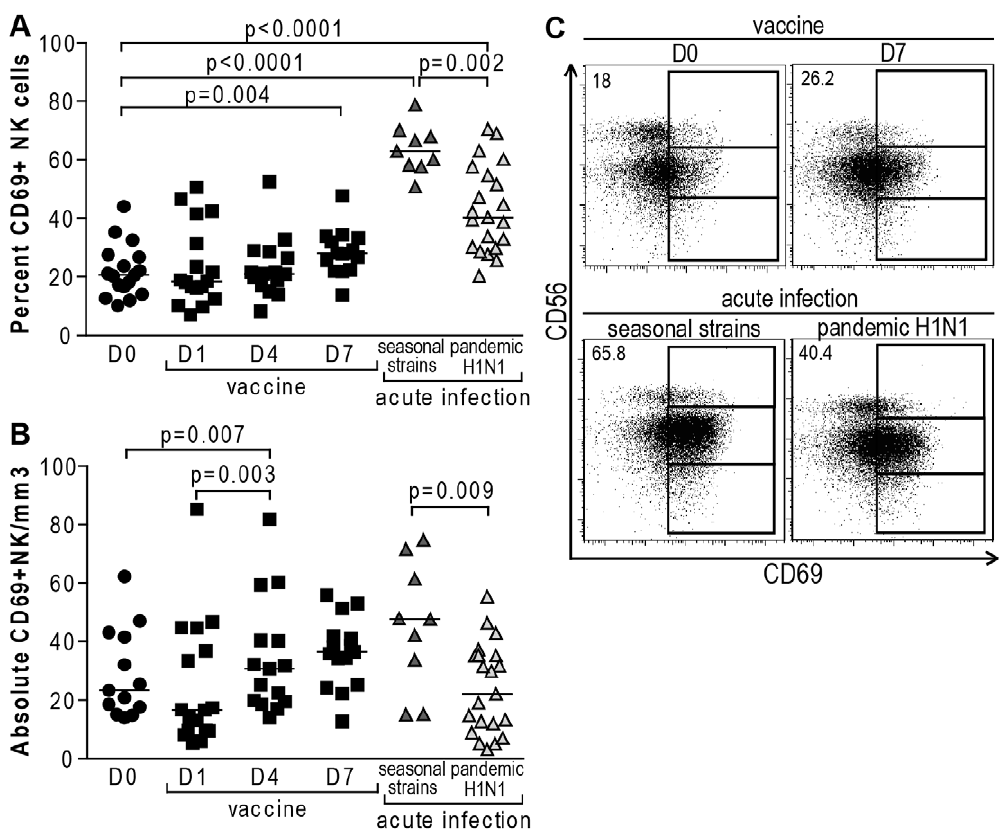
Figure 2. Changes in CD69 expression on NK cells in response to influenza infection and vaccination. Dot plots represent (A), percentages and (B), absolute numbers of CD69 + NK cells from 17 subjects prior to influenza vaccination, and at day 1, 4 and 7 post-vaccination, 9 N patients with acute seasonal influenza and 21 with acute 2009 pandemic H1N1 influenza virus infection. Complete blood counts at baseline were , healthy subjects prior vaccination; & , healthy subjects post-vaccination; dark grey m , acutely only available for 13 of the vaccinated subjects. ( infected with 2009 seasonal influenza strains; light grey m , acutely infected with 2009 pandemic H1N1 influenza virus). (C) Representative primary flow panels show percentages of CD69 + CD56 bright , CD56 dim and CD56 neg NK cells prior to and 7 days post-vaccination and in seasonal and pandemic influenza infection. Percentages of CD69 + total NK cells are indicated.